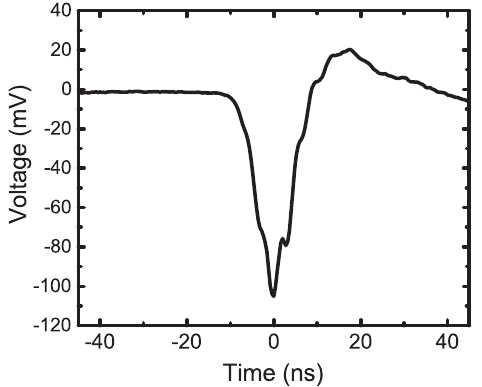
FIG. 5. Photocurrent of LaB 6 by excitation with 355 nm at a cathode temperature of 1400